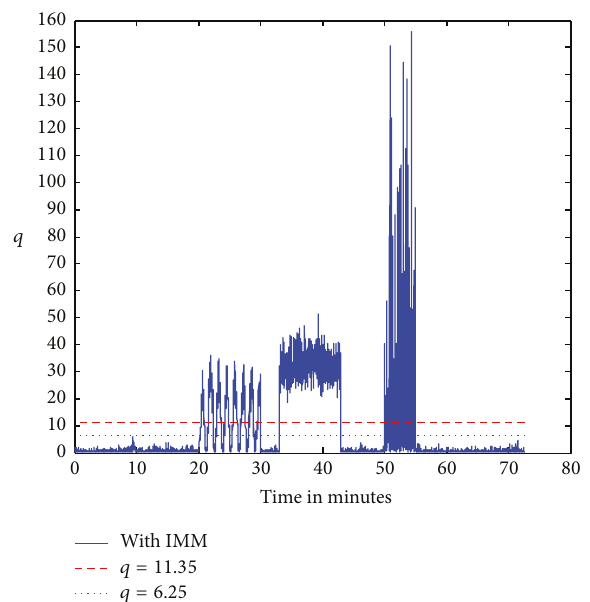
Figure 3: Attack detection curve together based on the proposed fuzzy attack detection/isolation fusion